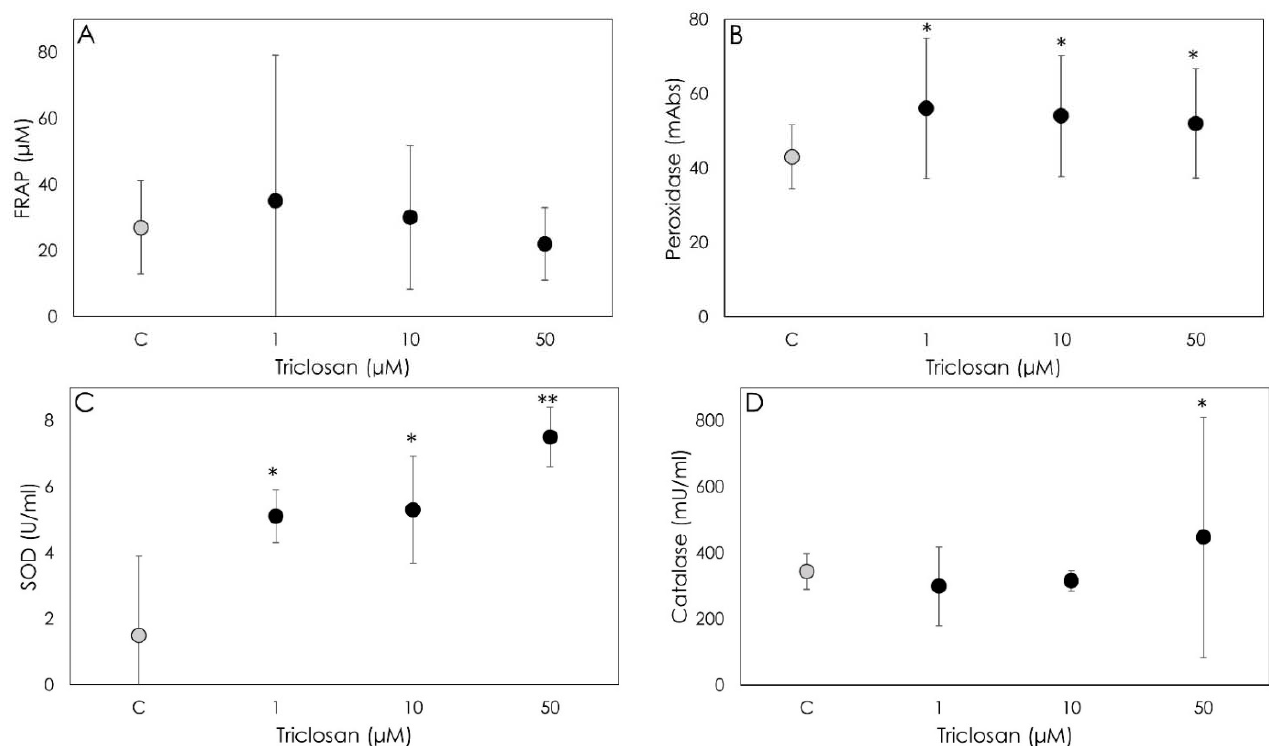
Figure 4. Results of non-enzymatic scavenging activity by porcine granulosa cells treated for 48 h with Triclosan (1, 10 or 50 μ M) using the FRAP assay (( A ); μ M), on peroxidase activity (( B ); milliAbs), superoxide dismutase activity (( C ); U/mL) and on catalase activity (( D ); mU/mL). Data represent the mean ± SD of six replicates/treatment repeated in five different experiments (n = 30). Asterisks on points indicate that the data show significant differences ( p < 0.05).